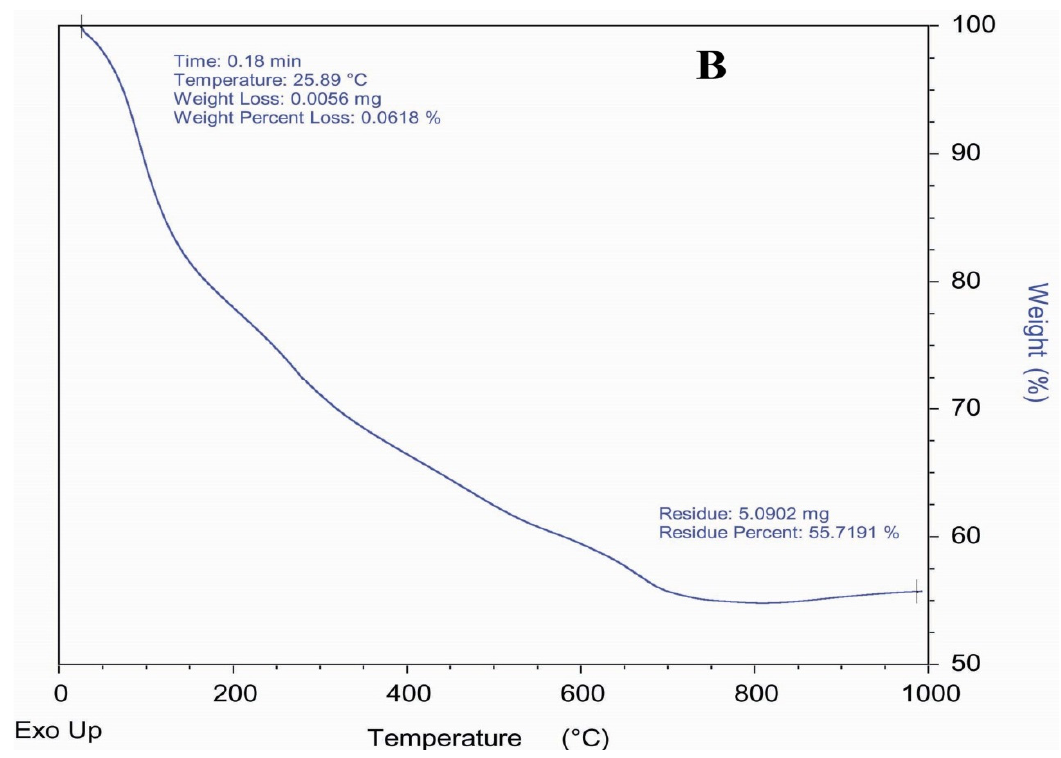
Figure 5. ( A ) Thermo Gravimetric Analysis (TGA) Curve of Compound 5 . ( B ) Thermo Gravimetric Analysis (TGA) Curve of Compound 6 .